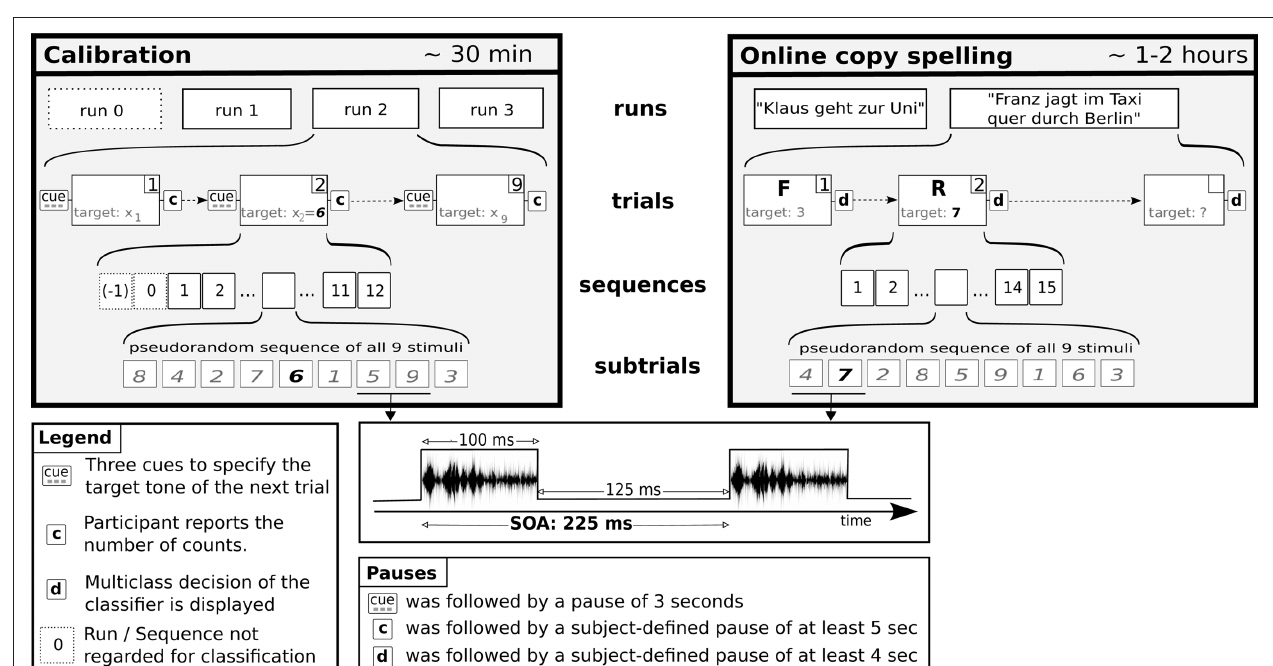
FIguRE 1 | Visualization of the experimental design of the experiment.